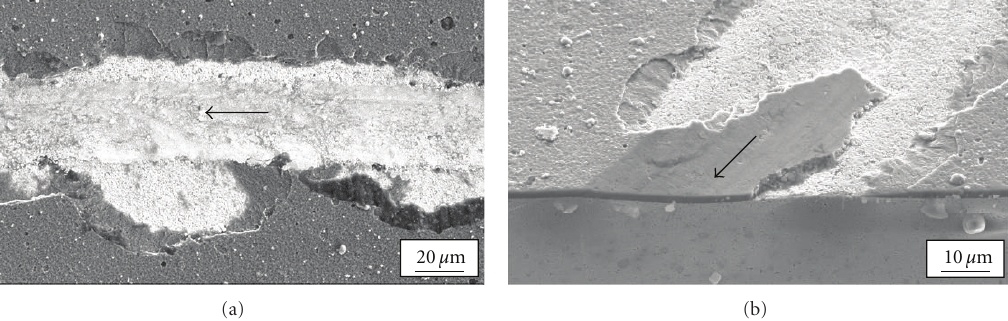
Figure 10: Complete exposure of the cemented carbide substrate due to continuous interfacial spalling (adhesive failure) within the circular wear track after a large number of repeated contacts ( N > 1000) for Ti 0 . 34 Al 0 . 66 N coating. The arrows indicate the scratching direction.